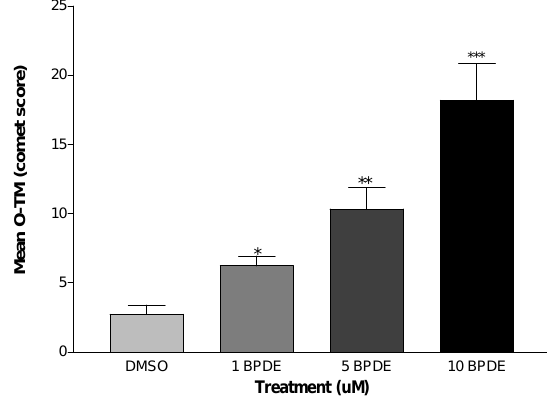
Figure 5 : Comet assay analysis of DNA strand breaks in DU145 prostate carcinoma cell line after 48 hours treatment with BPDE. The Comet assay analysis demonstrates that the degree of DNA damage by BPDE was concentration dependent. The symbol (*) indicates that the olive tail moment was statistically different from the control. The symbol (**) indicates that the olive tail moment was statistically different from the 5 μ M BPDE treatment group. The symbol (***) indicates that the olive tail moment was statistically different from 10 μ M BPDE treatment group at a significance of